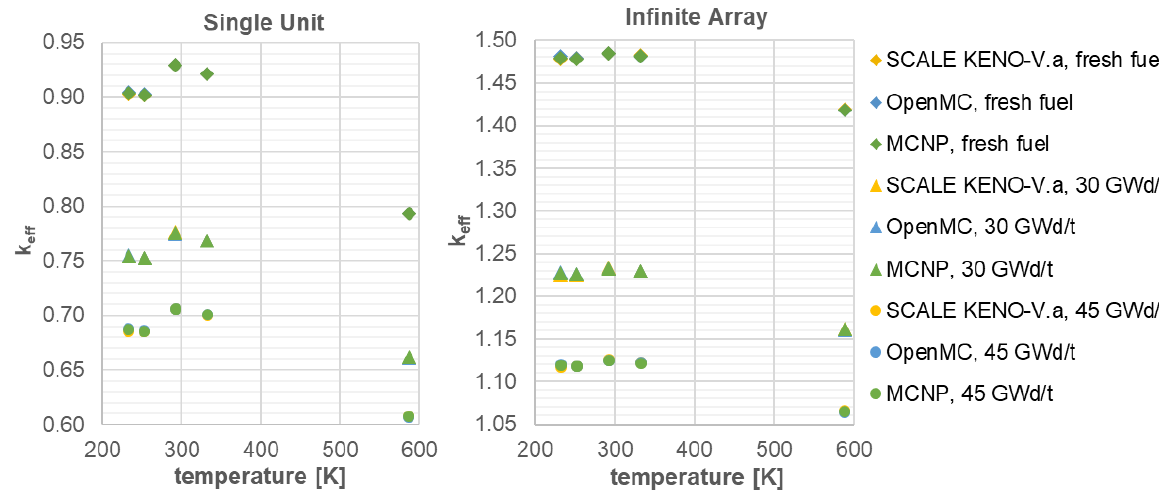
Figure 2. Calculated neutron multiplication factors k